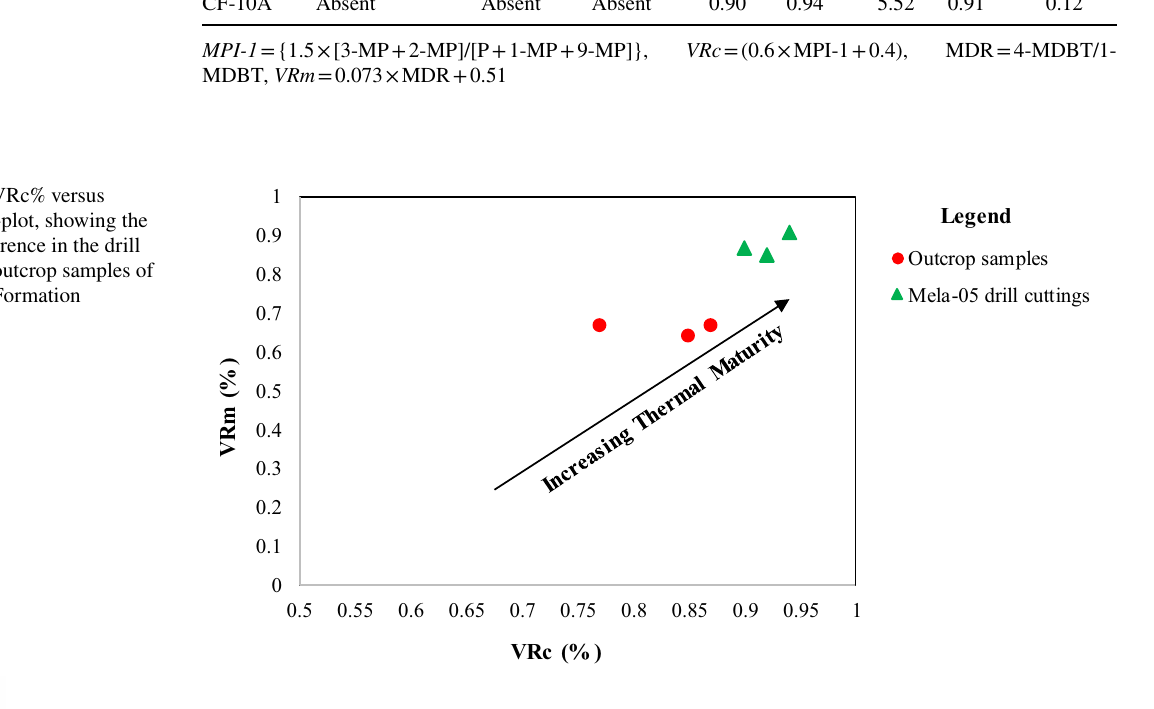
and environment of deposition parameters based on saturate and aromatic hydrocarbons in the Chichali Formation